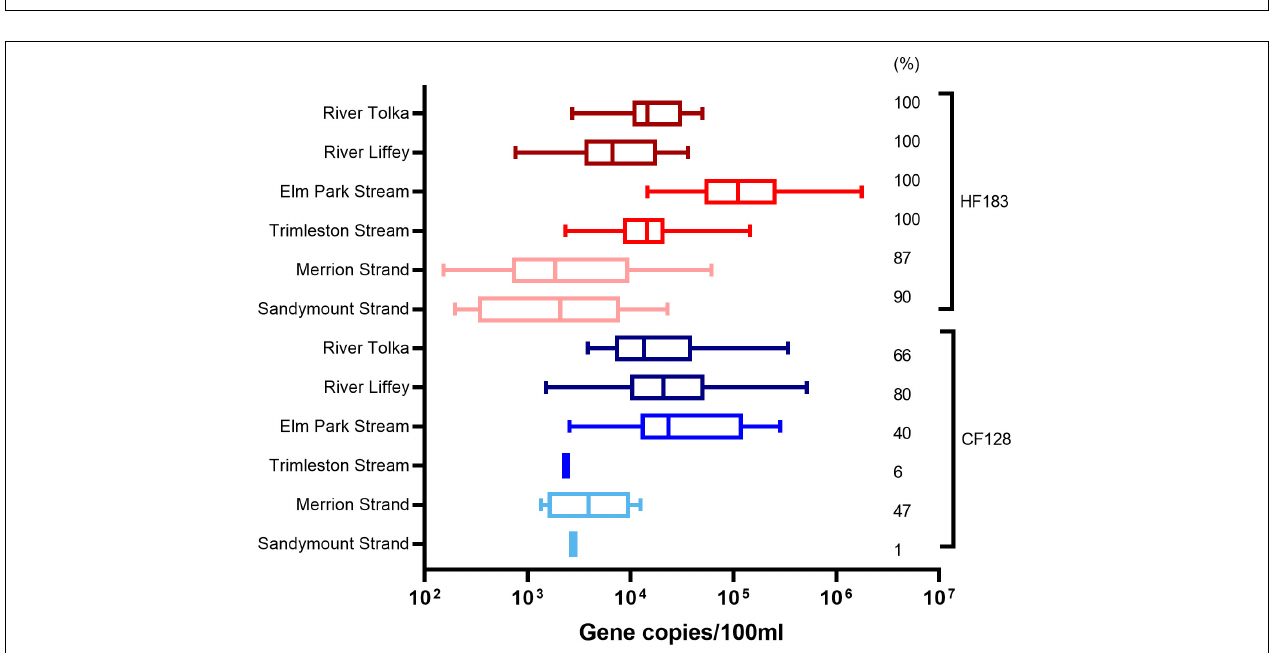
FIGURE 2 | Levels of the fecal indicators Escherichia coli , intestinal enterococci (I.E.). The dots show the concentration of each sample and the median are indicated as a horizontal line.